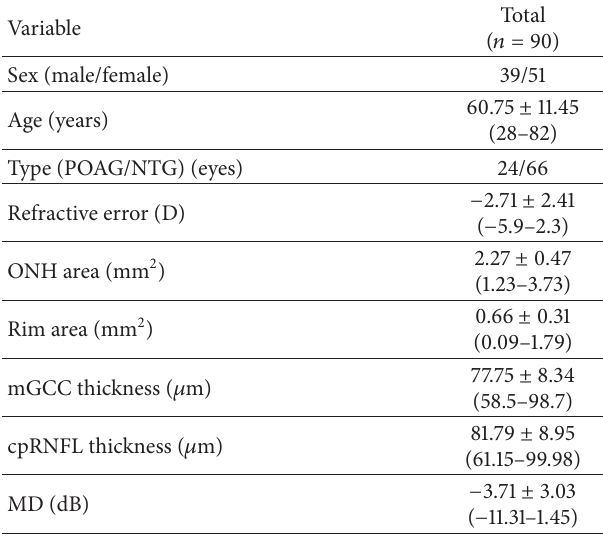
Table 1: Demographics of the study participants ( 𝑛 = 90 ).